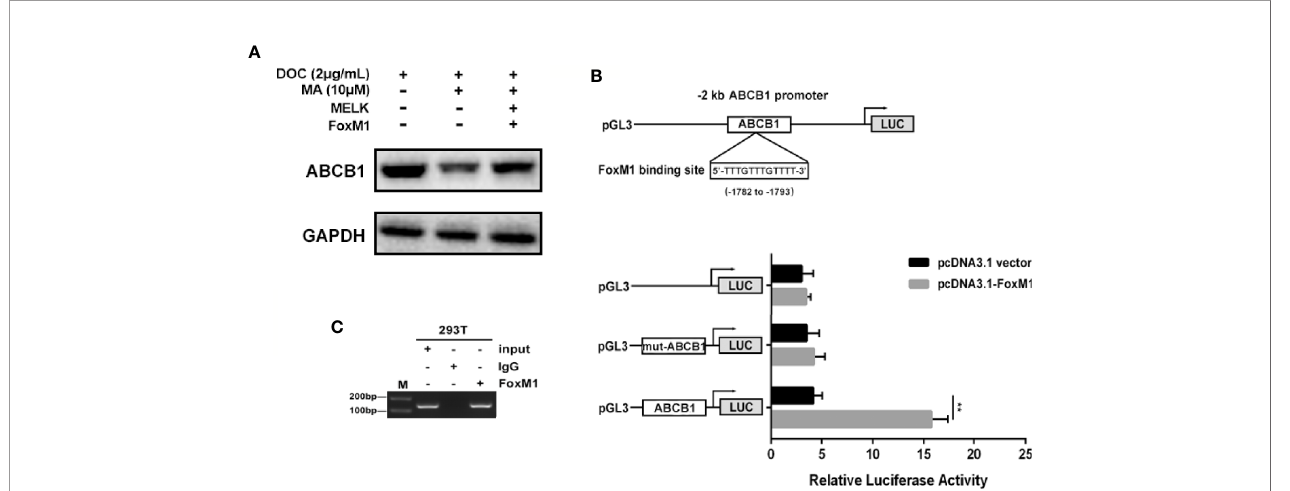
FIGURE 7 | The association of ABCB1 expression and MELK-FoxM1 signaling cascade. (A) The expression of ABCB1 in MDA-MB-231/DOC cells with indicated treatment. (B) The predicted position of FoxM1 binding site in -2 kb ABCB1 promoter, and veri fi ed by dual-luciferase reporter assay in HEK293T cells. ** p < 0.01 vs. pcDNA3.1 group. (C) Direct binding of FoxM1 to ABCB1 promoter region was determined using ChIP assay. All data were presented as means ± SD with three independent experiments, and triplicate repeats were included in each experiment.